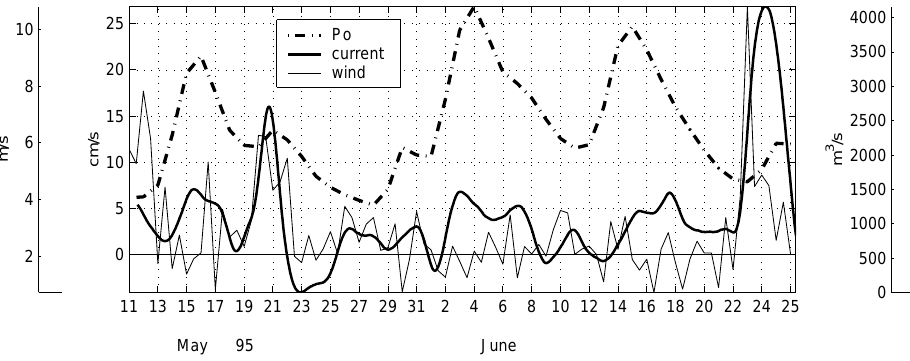
Fig. 11. Comparison between Po River discharge, wind intensity and alongshore low-pass current at mooring B03.